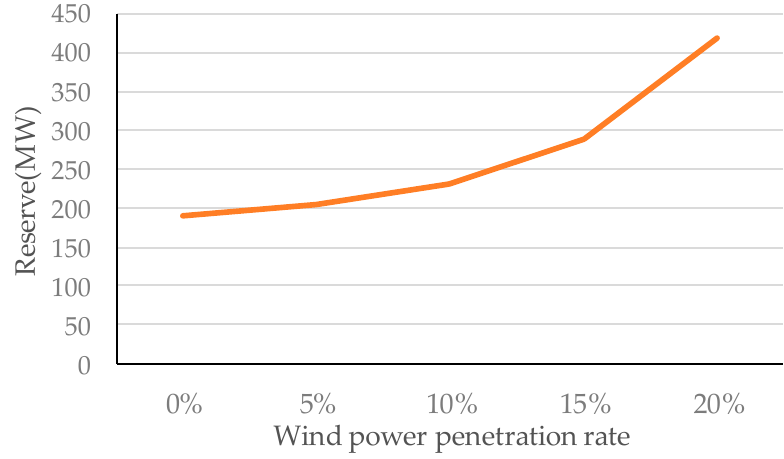
Figure 9. Comparison of reserve under different wind power penetration rates.